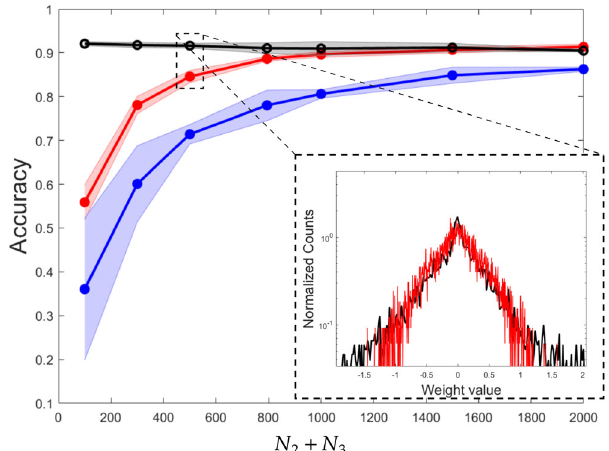
Fig. 5 Wide linear scheme. A three layers neural network is considered. The accuracy of the neural network is plotted as a function of the number of parameters that we chose to train with the spectral algorithm, N 2 + N 3 . The red line reports on the performance of the spectral training. The blue line refers to the neural network trained in direct space: the optimisation runs on N 2 + N 3 parameters, a subset of the total number of adjustable weights N N + N N 1 2 2 3 . The black line stands for the accuracy of the linear neural network when training the full set of N 1 N 2 + N 2 N 3 parameters. Notice that the reported accuracy is comparable to that obtained for a standard two- layers perceptron. Inset: the distribution of the entries of the equivalent perceptrons are plotted. The red curve refer to the spectral learning restricted to operate on the eigenvalues; the black pro fi le to the neural network trained in direct space, employing the full set of adjustable parameters. In both cases, the weights refer to the two-layers con fi guration obtained by retracting the intermediate linear layer employed during the learning stage.